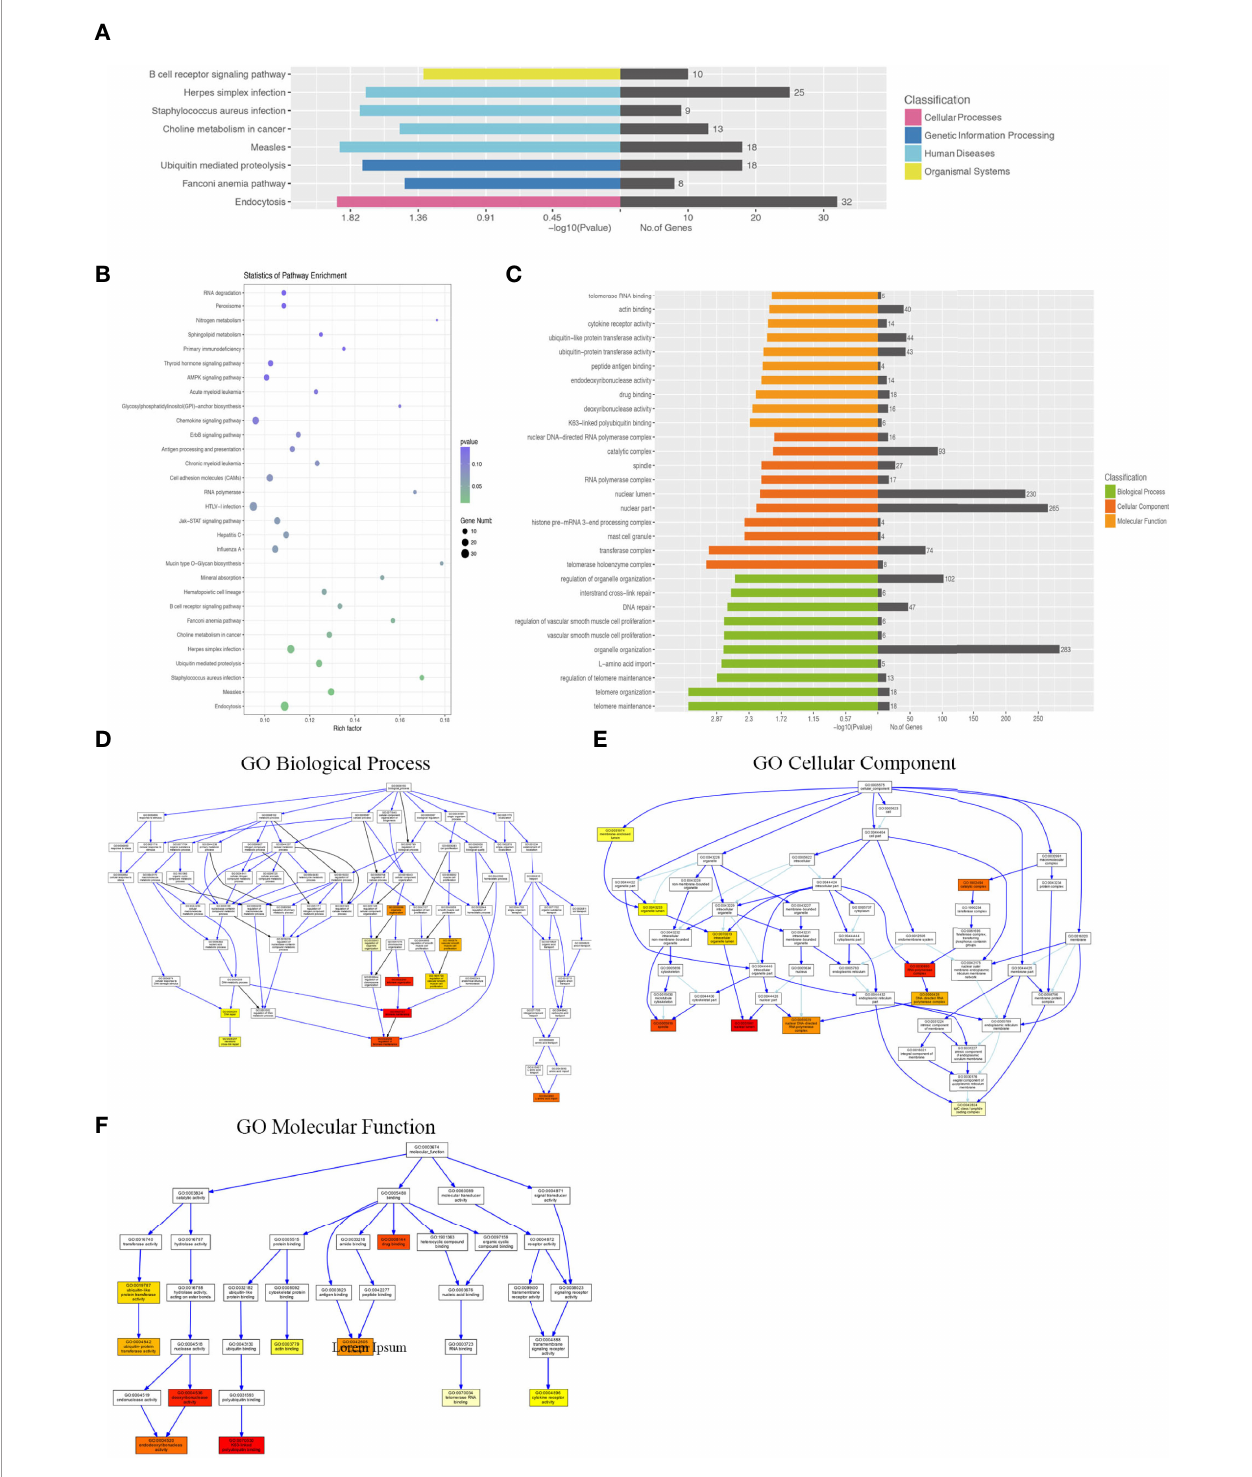
FIGURE 5 | KEGG pathway and GO analysis of differentially expressed lncRNA – target mRNAs between WT-PCP mice and BAFF-R – / – PCP mice. (A, B) KEGG pathway analysis of DEGs between WT-PCP mice and BAFF-R – / – PCP mice. (C) GO analysis of DEGs between WT-PCP mice and BAFF-R – / – PCP mice. (D) Changes in the biological processes of DEGs. (E) Changes in the cellular component of DEGs. (F) Changes in the molecular function of